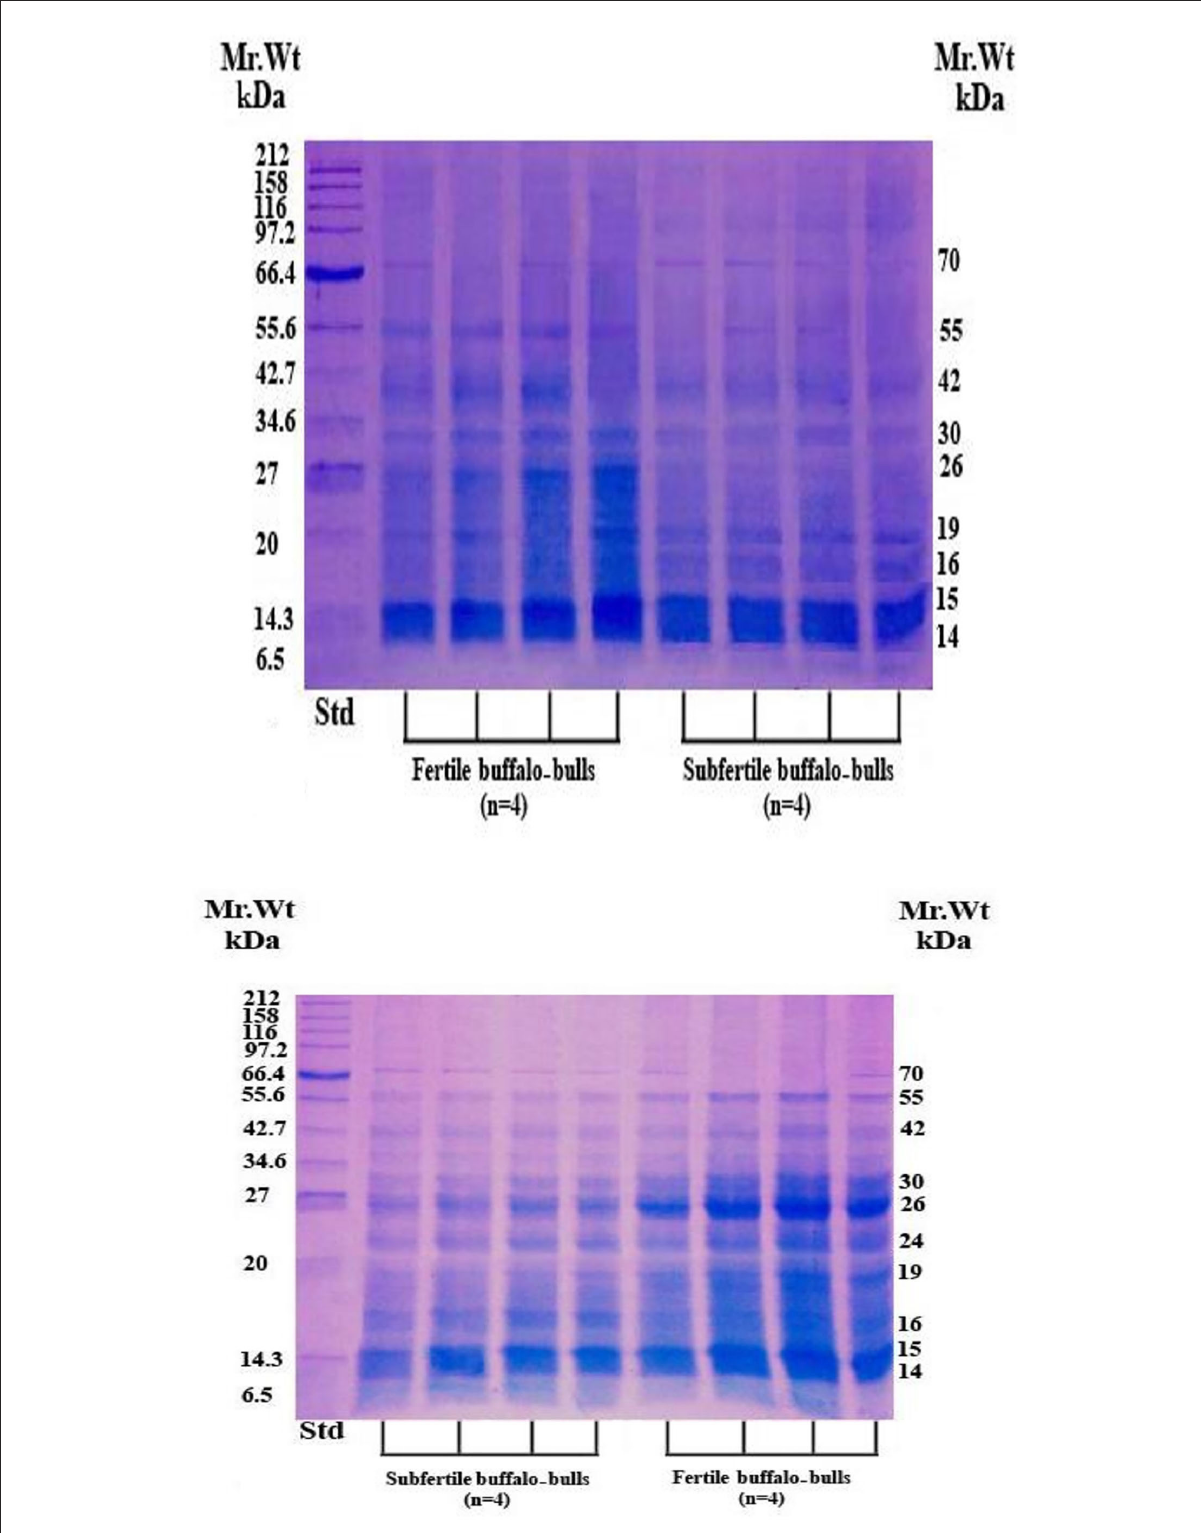
FIGURE1 SDS-PAGE of SP proteins in fertile and subfertile buffalo bulls. Bulls were classified into fertile and subfertile groups based on their conception rates. SP was collected by centrifugation (12,000 × g for 30min) of the collected semen samples. Reduction, denaturation, and separation of SP proteins on 15% polyacrylamide gel were performed in the presence of a broad-way (6.5–212 kDa) prestained protein marker. Separated protein bands were detected by Coomassie brilliant blue staining. Std, Standards; kDa, Kilo Dalton; Mr. Wt, Molecular